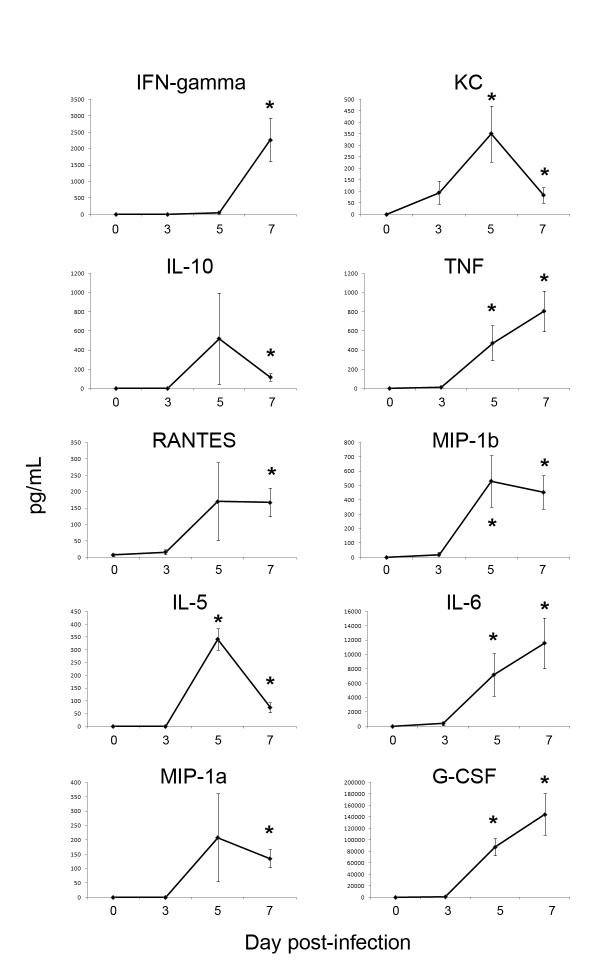
Cytokine and chemokine analysis. Concentrations of 17 different cytokines and chemokines in plasma was evaluated on days 0, 3, 5, and 7 post-infection (n = 6-7). *p < 0.05.